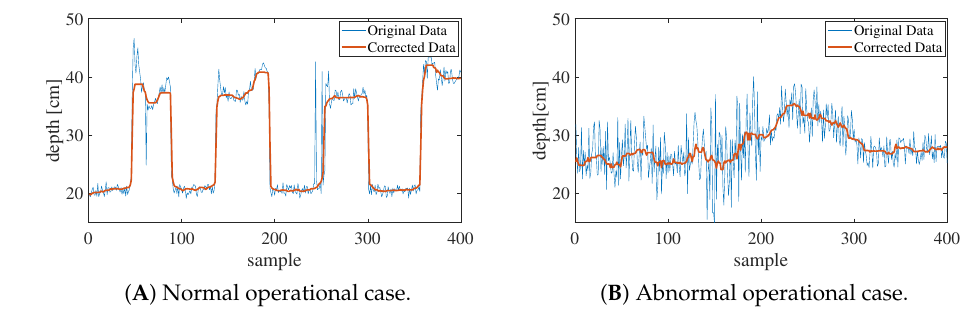
Figure 11. Fixation point depth data